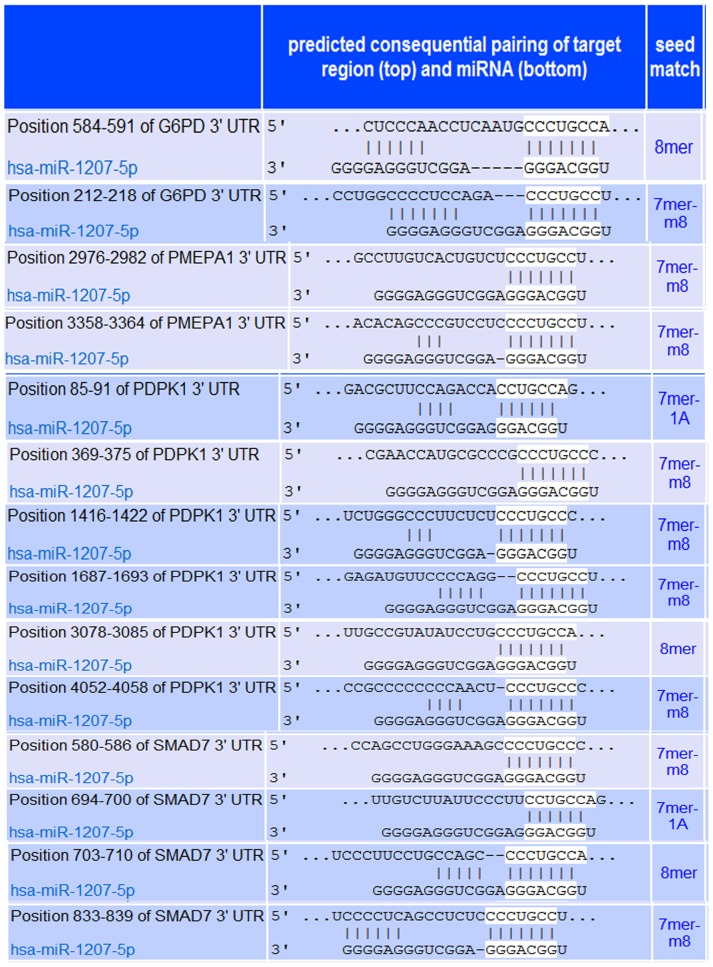
Predicted pairing of target region (top) and miR-1207-5p (bottom) according to TargetScan (www.targetscan.org).A total of 14 miR-1207-5p's target sites are predicted in the four target genes selected: G6PD, PMEPA1, PDPK1, and SMAD7. G6PD, glucose-6-phosphate dehydrogenase; PMEPA1, prostate transmembrane protein, androgen induced 1; PDPK1, 3-phosphoinositide dependent protein kinase-1; SMAD7, SMAD family member 7.